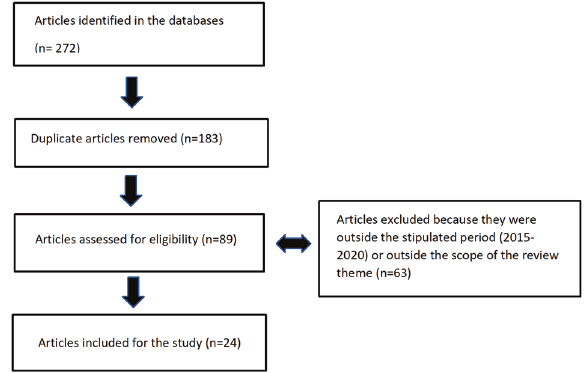
Fig. 1 Flow chart illustrating the second phase of the literature